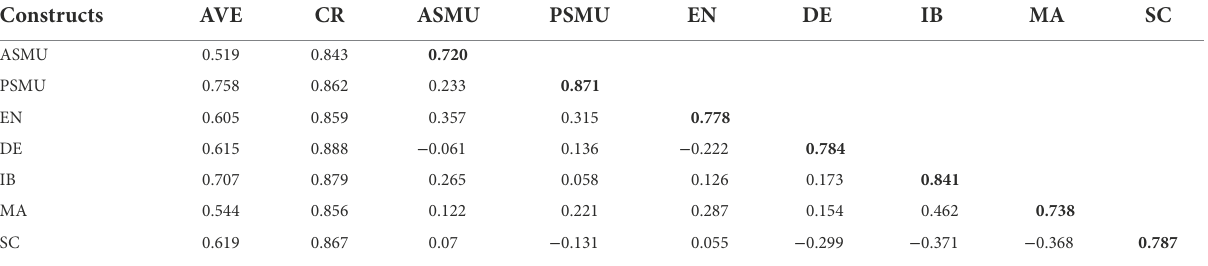
TABLE 2 Construct reliability and